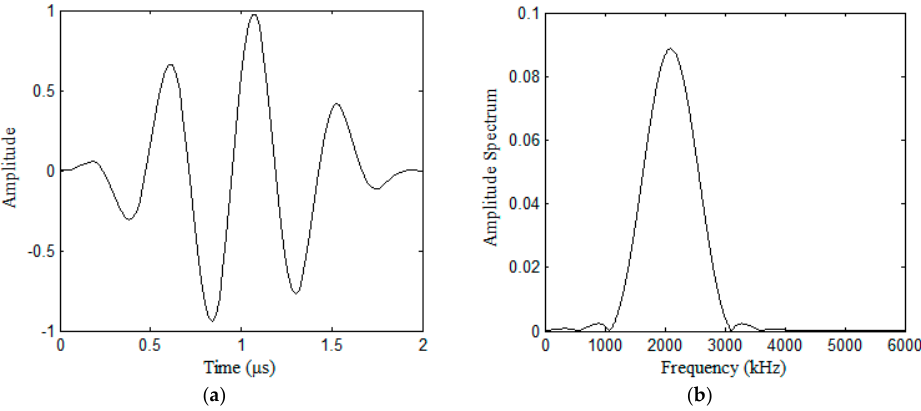
Figure 7. Excitation pulse in the time and frequency domains: ( a ) time domain; ( b ) frequency domain.